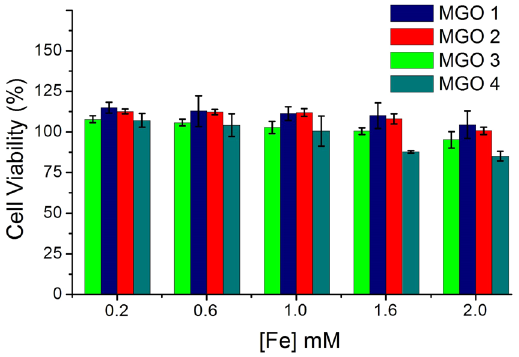
Figure 7. MTS assays of MGOs in MDA-MB-231 human breast adenocarcinoma epithelial